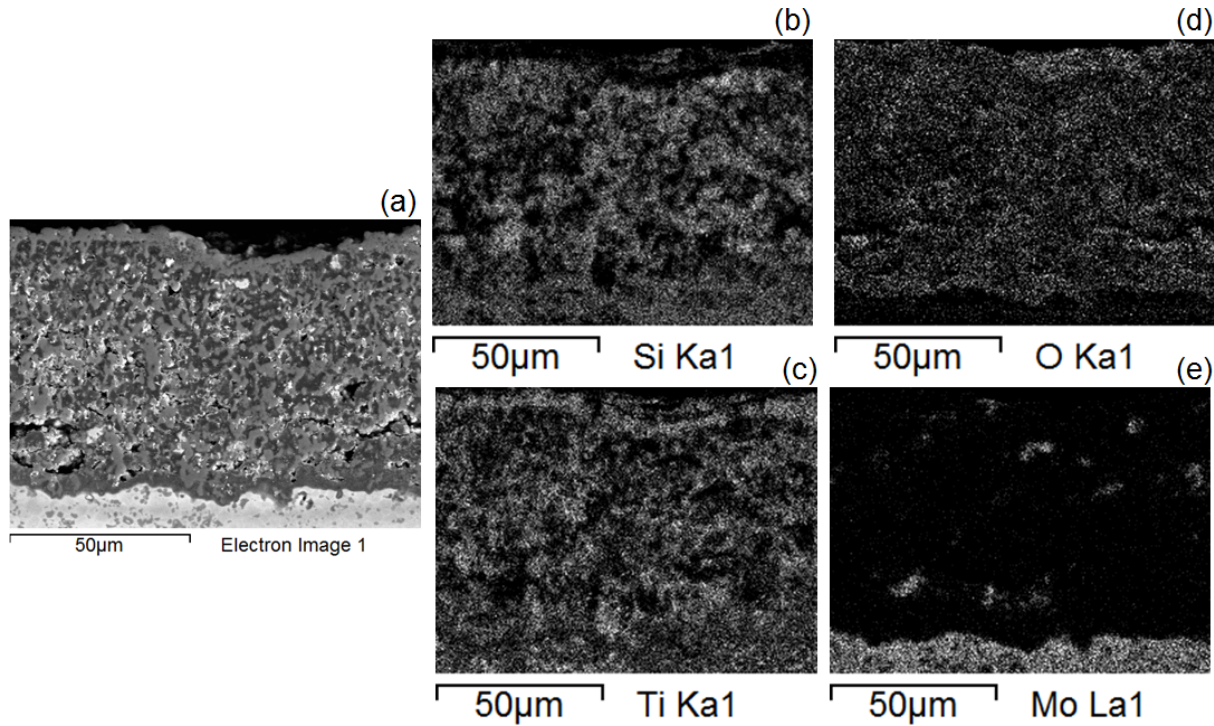
Figure 10: (a) Cross-sectional BSE image and EDS X-ray maps across the scale/alloy interface for (b) Si Ka, (c) Ti Ka, (d) O Ka and (e) Mo La.